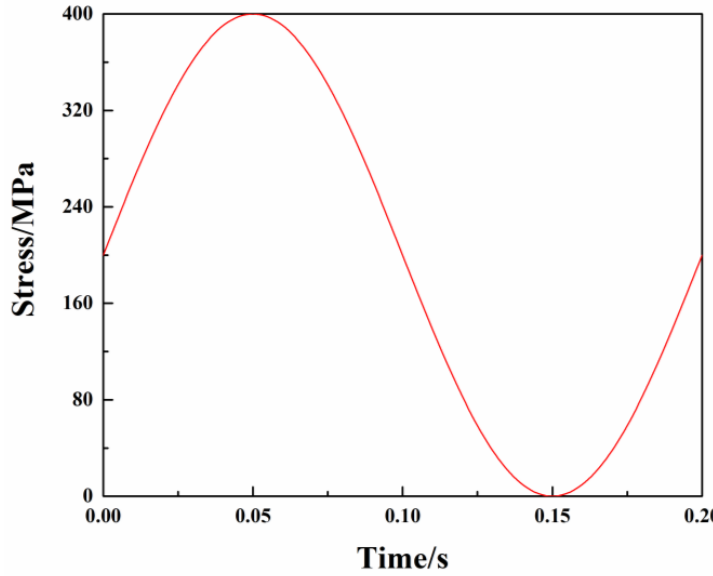
Figure 3. One cyclic loading for the low-cycle fatigue test.